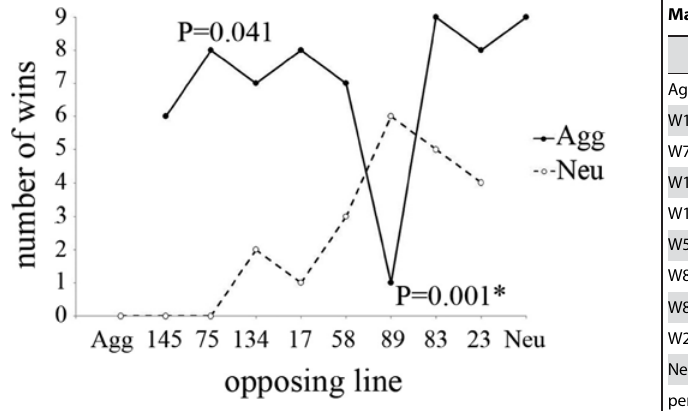
Figure 1. The number of wins of the Aggressive and Neutral lines when competed against the Winters inbred strains. Winters lines are ordered by mean level of territorial success from most to least successful. * significant under sequential Bonferroni for multiple testing